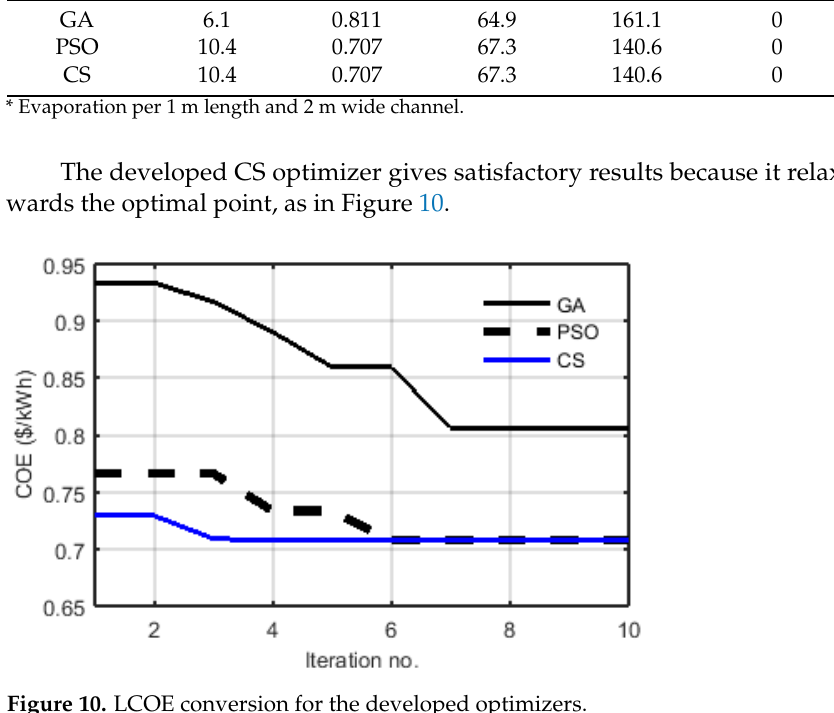
Figure 10. LCOE conversion for the developed optimizers. Both the CS optimizer and PSO recorded the same LCOE. However, GA shows undesirably higher LCOE, which corresponds to an increase in the TNPC by 14.5%, referred to as the CS optimizer. The annual energy share is demonstrated in Figure 11, where the canal-top PV covers about half of load demand.